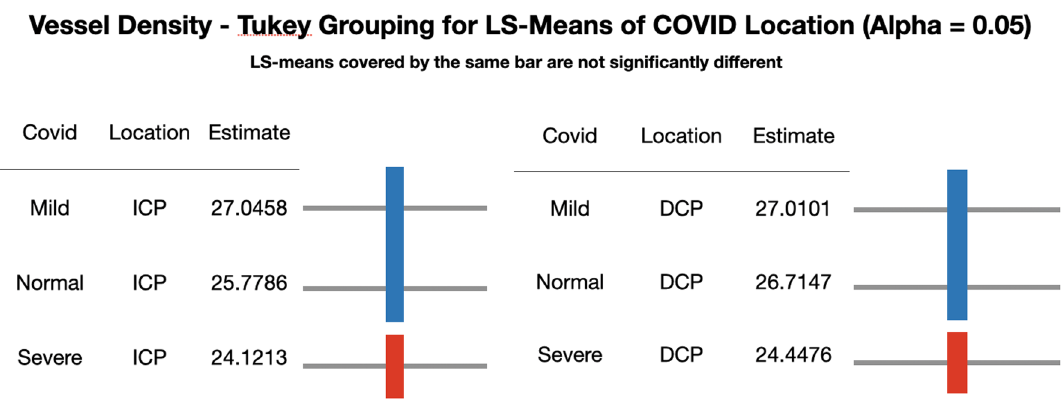
Figure 3. Comparison of least square means of three COVID-19 levels within ICP and DCP. ICP intermediate capillary plexus, DCP deep capillary plexus, COVID-19 coronavirus